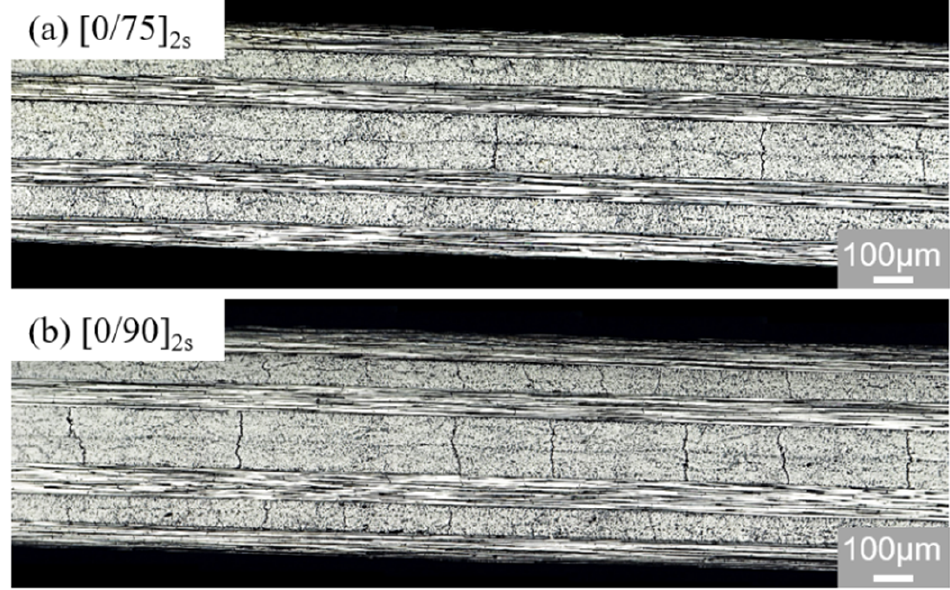
Figure 7. Images of the matrix cracks in the off-axis plies of the [0/75] 2s and [0/90] 2s laminates at the load level of 80%: ( a ) [0/75] 2s laminate; ( b ) [0/90] 2s laminate. Microscopic observations of the damage progression in the width direction of the specimens were carried out for the [0/75] 2s and [0/90] 2s specimens. Typical observation results of [0/75] 2s and [0/90] 2s specimens are presented in Figure 8. From Figure 8, comparing the damage images at the free edge, much more fiber breakages (marked by yellow arrows) are observed at the free edge (Figure 8a,b), but very few are observed in the central section (Figure 8c,d). These results demonstrate that fiber breakages are limited to the free edge of the tested specimens attributed to defects on the fibers of the 0 ◦ plies caused in the polishing process. Inversely, matrix cracks are observed both at the free edge and in the central section, indicating that similar matrix cracks occur not only at the free edge, but also in any section in the width direction. Besides, matrix cracks propagate along the off-axial orientation through the width in off-axis plies. In addition, delamination-like damage is observed at the crack tips of some matrix cracks. Similar observation results were obtained for the [0/90] 2s laminate, which are shown in Figure